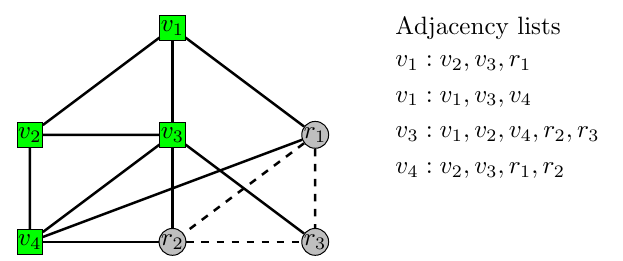
Figure 4. Visited and reached nodes in the sample of the Facebook social graph. We give an example of how our simulations treat differently the visited and reached nodes, as defined by the Breadth-First-Search (BFS) crawling on the Facebook social graph 28,29 . In the example, the visited nodes, that is, the nodes completely explored by the BFS are v 1 , v 2 , v 3 , and v 4 (green squares), while the reached nodes, that is, the nodes only reached by the BFS are r 1 , r 2 , and r 3 (gray circles). All edges are unweighted and denote the fact that the two endpoints of an edge are friends in the Facebook social graph. However, while the edges incident to visited nodes (solid lines) are included in the network used in our simulations, the edges between two reached nodes (dashed lines) are not considered (even if the corresponding two Facebook users are friends). On the right, we show the adjacency lists that would be used in our simulations with regards to the aforementioned example: As it can be seen, there is no adjacency list for the reached nodes, since the neighborhood of these nodes has not been fully explored.